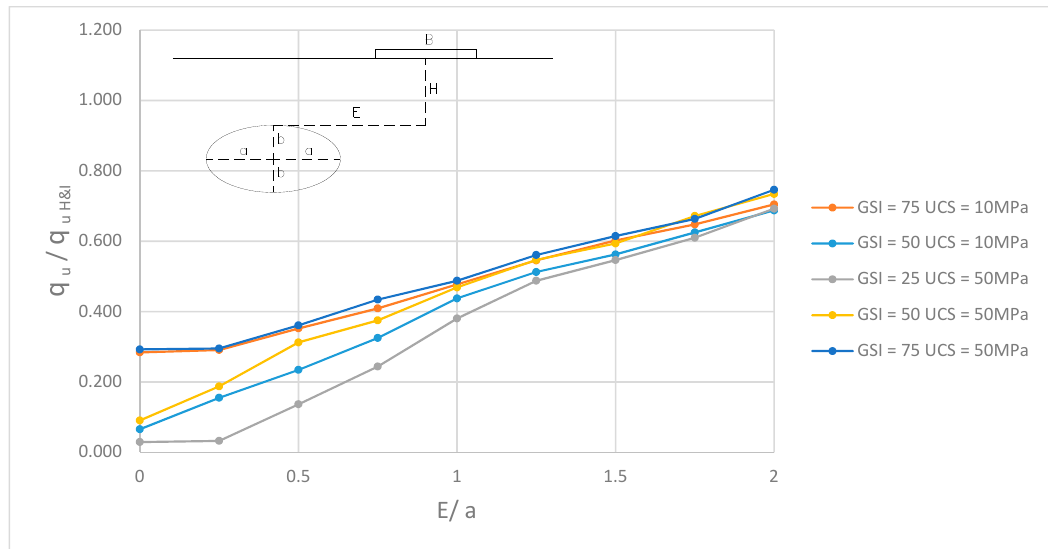
Figure 11. Influence of the geomechanical parameters of the rock, UCS and GSI, on the ultimate bearing capacity value when varying the load eccentricity.